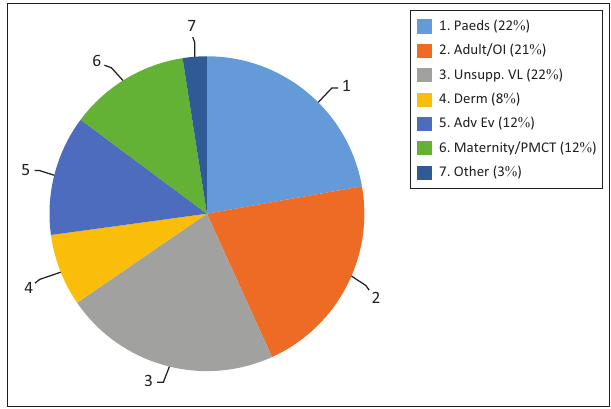
FIGURE 1: Types of cases discussed ( n =